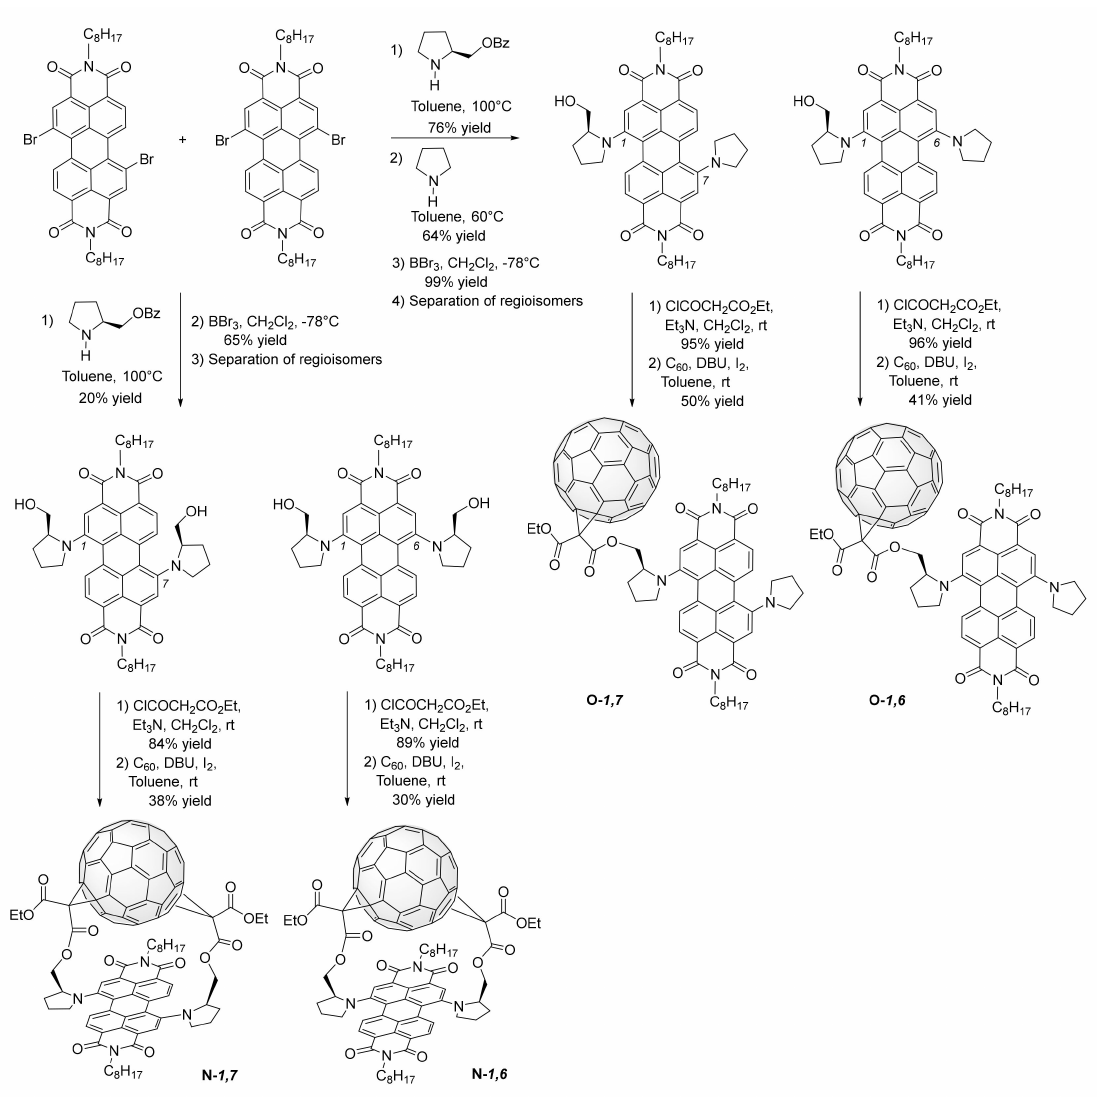
Scheme 9. Synthesis of 1,6 and 1,7-regioisomers of single and double-bridged pyrrolidino-substituted PDI-C 60 dyads N and O , respectively, by R.K. Dubey, H. Lemmetyinen and